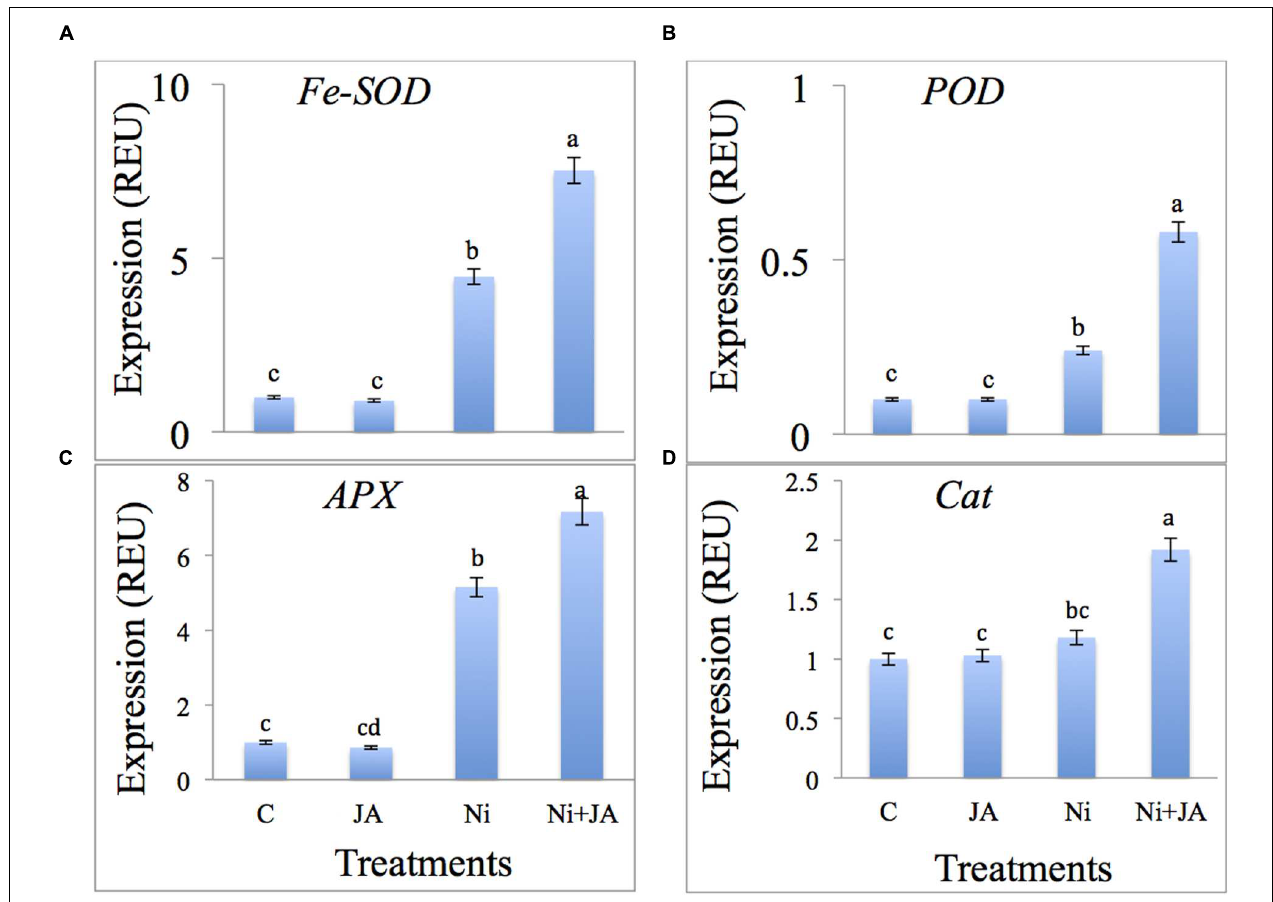
FIGURE 4 | Expression level of (A) Fe-SOD , (B) POD , (C) APX, and (D) CAT genes (REU relative expression unit) in soybean subjected to Ni and JA individually and in combination. Different letters indicate significant difference between means at p ≤ 0.05 (DMRT). Values are means ± SE ( n =